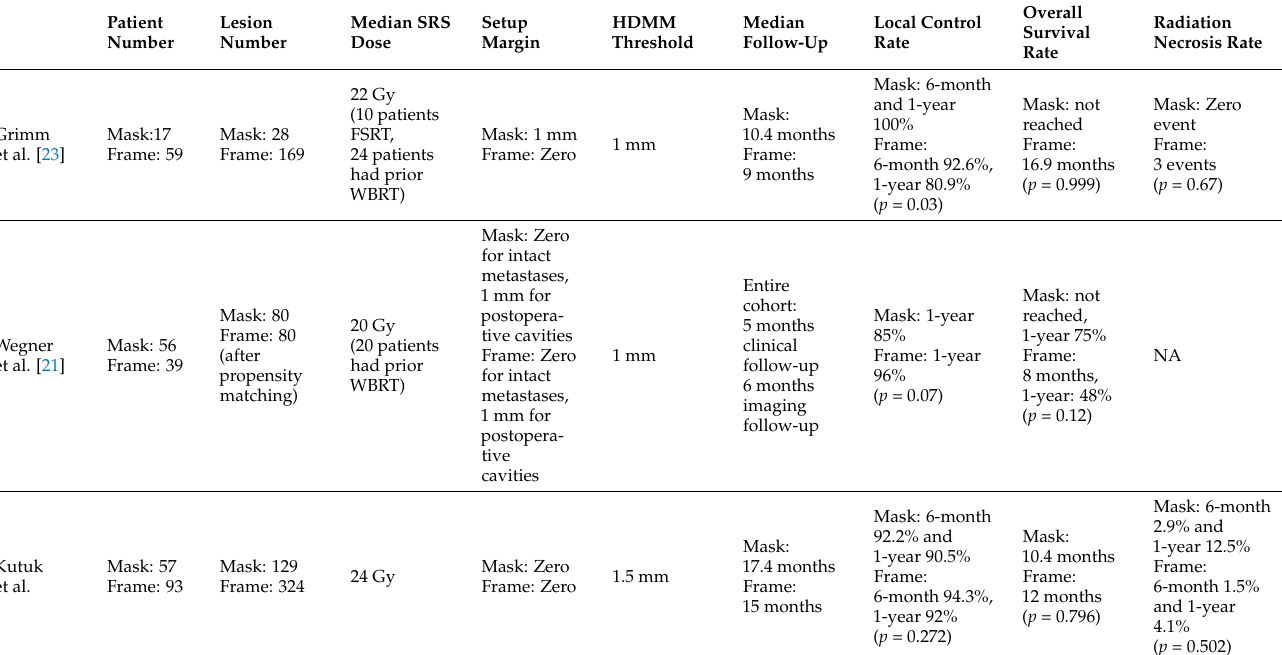
Table 3. Overview summary of Gamma Knife ® Icon TM